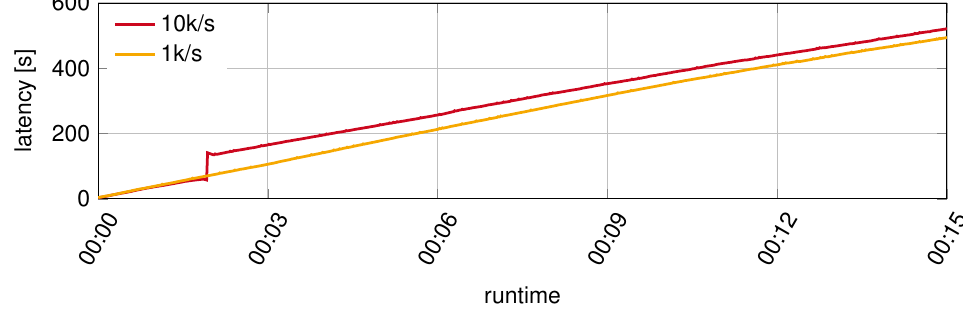
Figure 8. Progression of the processing latency for a one-second time